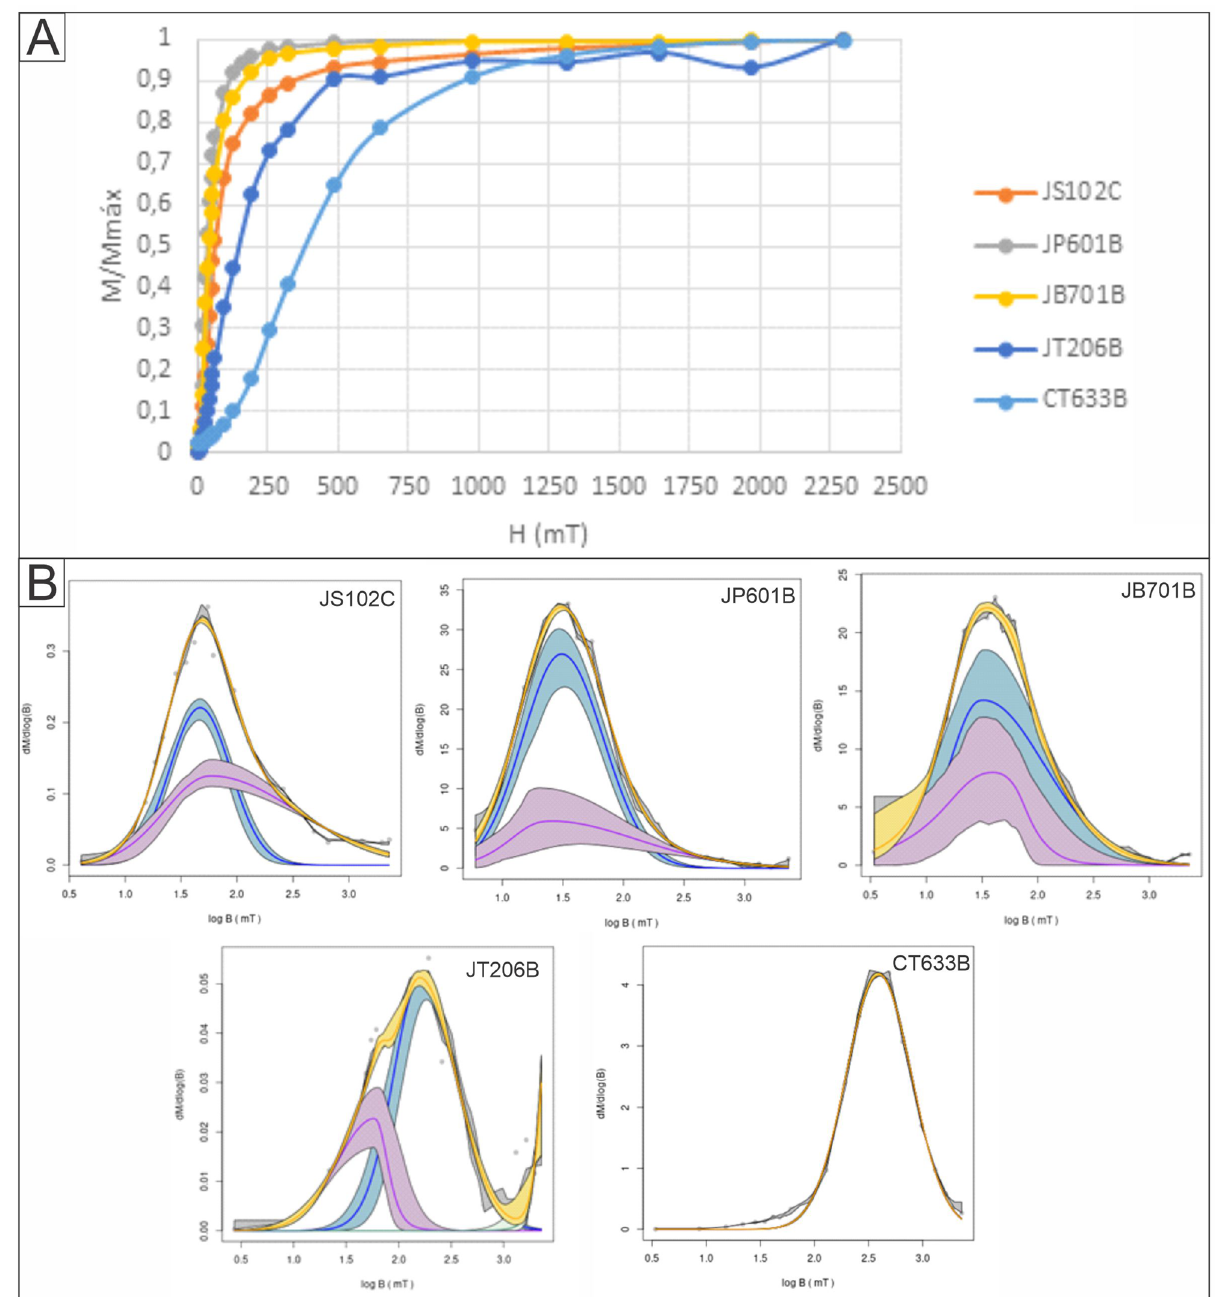
Figure 5. ( A ) Normalized acquisition curves of IRM (Isothermal Remanence Magnetization); H (applied magnetic field), M (susceptibility). ( B ) Model coercivity spectra 66 . Data points are denoted by dots. (Bh = coercivity). The yellow line represents the total coercivity spectra. Blue and purple lines represent de individual contribution of the different coercivity components. Blue and purple shadows represent 95% confidence